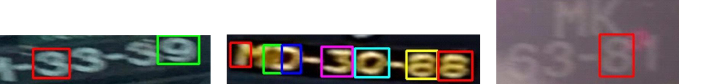
Figure 10. Some segmentation failures including missing detections and incorrect segmentation.